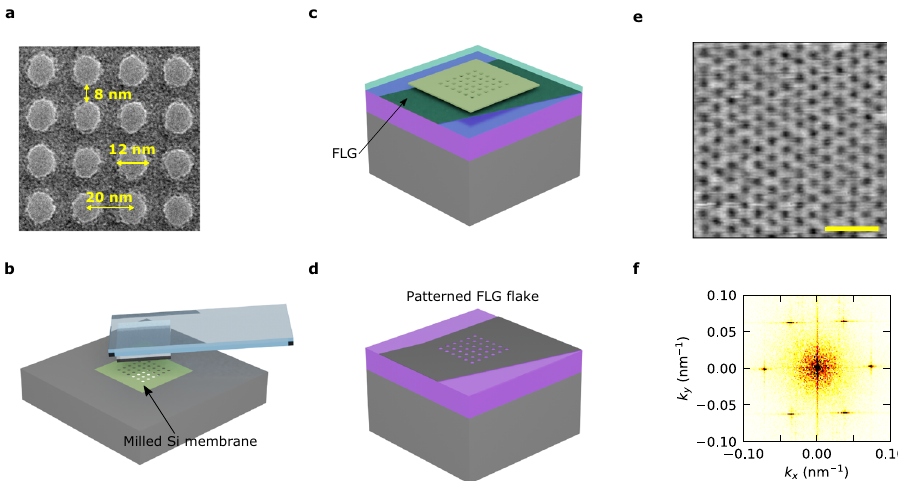
Fig. 2 | Fabrication process of a patterned few layer graphene (FLG) gate electrode. a Transmission electron microscope (TEM) image of a thin suspended silicon membrane which has previously been milled with a He focused-ion beam (FIB). b Themembraneistransferredwithapolypropylenecarbonate(PPC)coated polydimethylsiloxane (PDMS) stamp onto a FLG fl ake coated with a thin layer of poly(methyl methacrylate) (PMMA). c The sample is etched following a standard